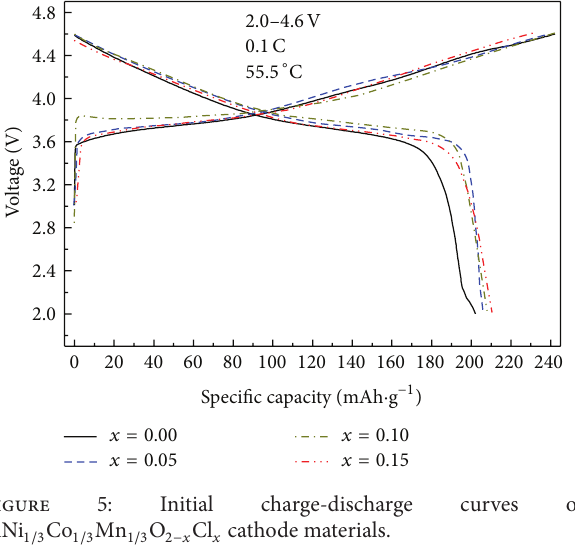
Figure 6: Cyclic performance of LiNi 1/3 Co 1/3 Mn 1/3 O 2−𝑥 Cl 𝑥 cath- ode materials at different